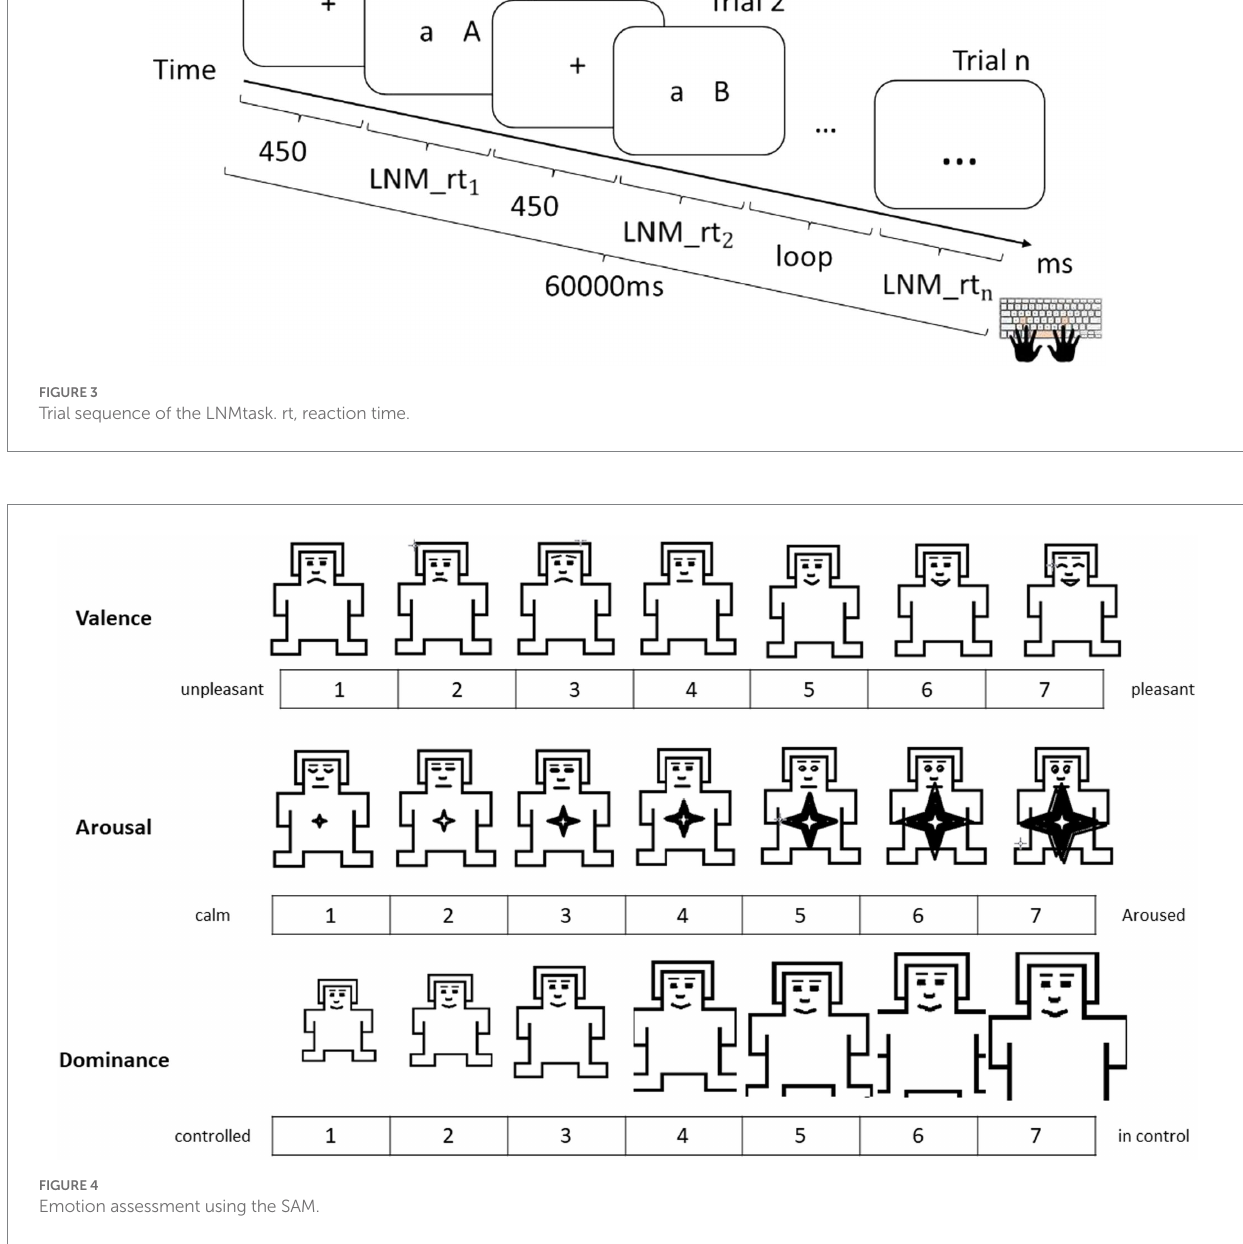
FIGURE 4 Emotion assessment using the